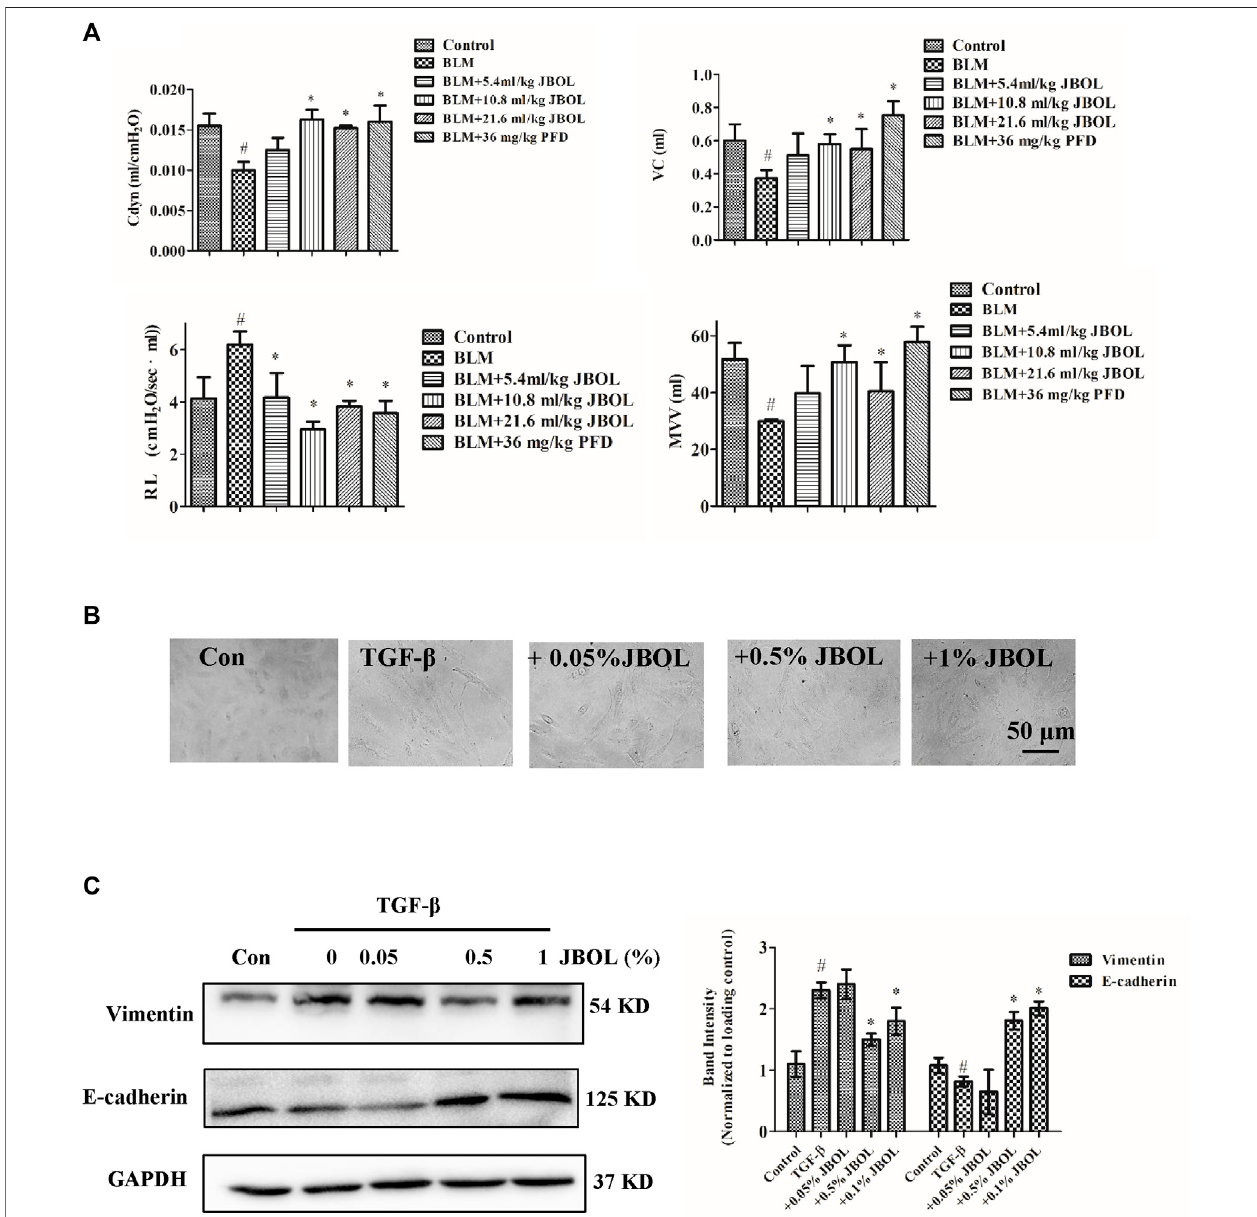
FIGURE 8 | Evaluation ofJBOL effects on IPF in vivo and in vitro . (A) Pulmonary function test in the BLM-treated rats with JBOL or pirfenidone (PFD).n = 3 – 6, * p < 0.05. (B) MorphologicalchangesinA549cellstreatedwithTGF- β 1and/orJBOL. (C) TheexpressionofvimentinandE-cadherin.n=3,# p < 0.05vscontrol;* p < 0.05vs the TGF- β 1-treated